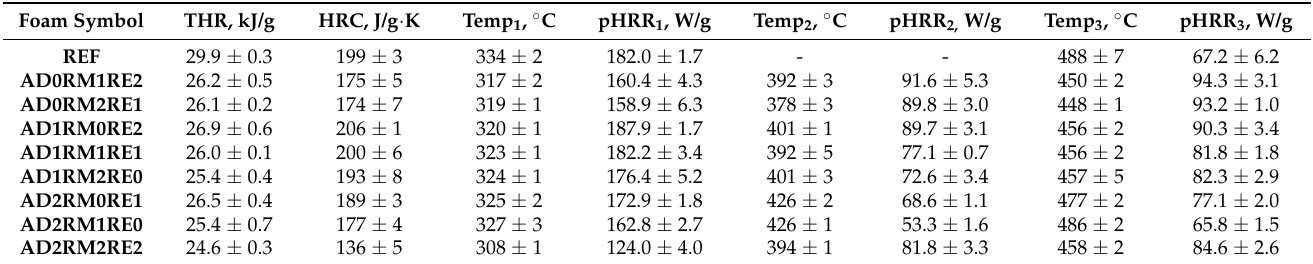
Table 6. Combustion parameters obtained with the pyrolysis and combustion microcalorimeter (PCFC).